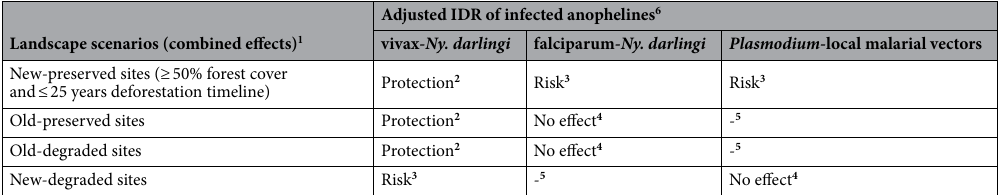
Table 4. Risk/protection landscape scenarios based on incidence density ratio of infected anophelines and the combined effects of accumulated deforestation and the deforestation timeline adjusted by control variables. 1 preserved and new sites (14/41 = 34.2%), preserved and old sites (8/41 = 19.5%), degraded and new sites (3/41 = 7.3%), and degraded and old sites (16/41 = 39%). 2 Adjusted IDR of infected anophelines < 1, p < 0.05, and baseline = new-degraded sites. 3 Adjusted IDR of infected anophelines > 1, p < 0.05. 4 Adjusted IDR of infected anophelines = 1, and baseline = new-preserved sites. 5 No infected anopheline found. 6 Incidence density ratio (IDR) was adjusted by the number of collectors (3 or 4) and the period of collection (12 h or 6 h).